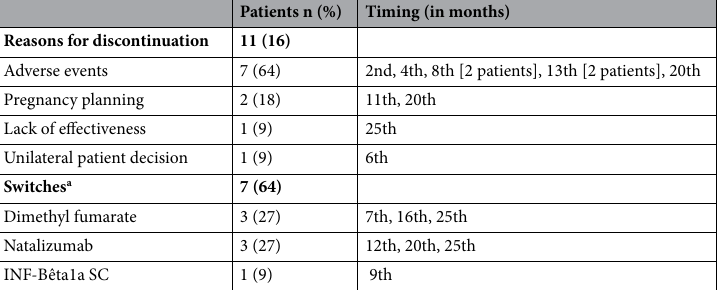
Table 4. Reasons for fingolimod discontinuation and switching to other DMTs (n = 67 patients). DMT: drug modified therapy; IFN: interferon; n: number; SC: subcutaneous; a Two patients were lost to follow-up after discontinuation, so information on the switch is missing.